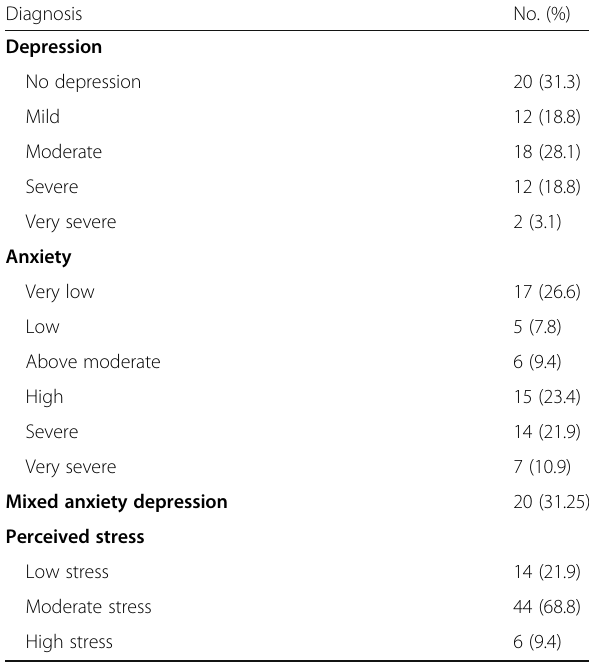
Table 2 Distribution of psychiatric diagnoses in the cases regarding psychiatric assessment scales ( n = 64) Diagnosis